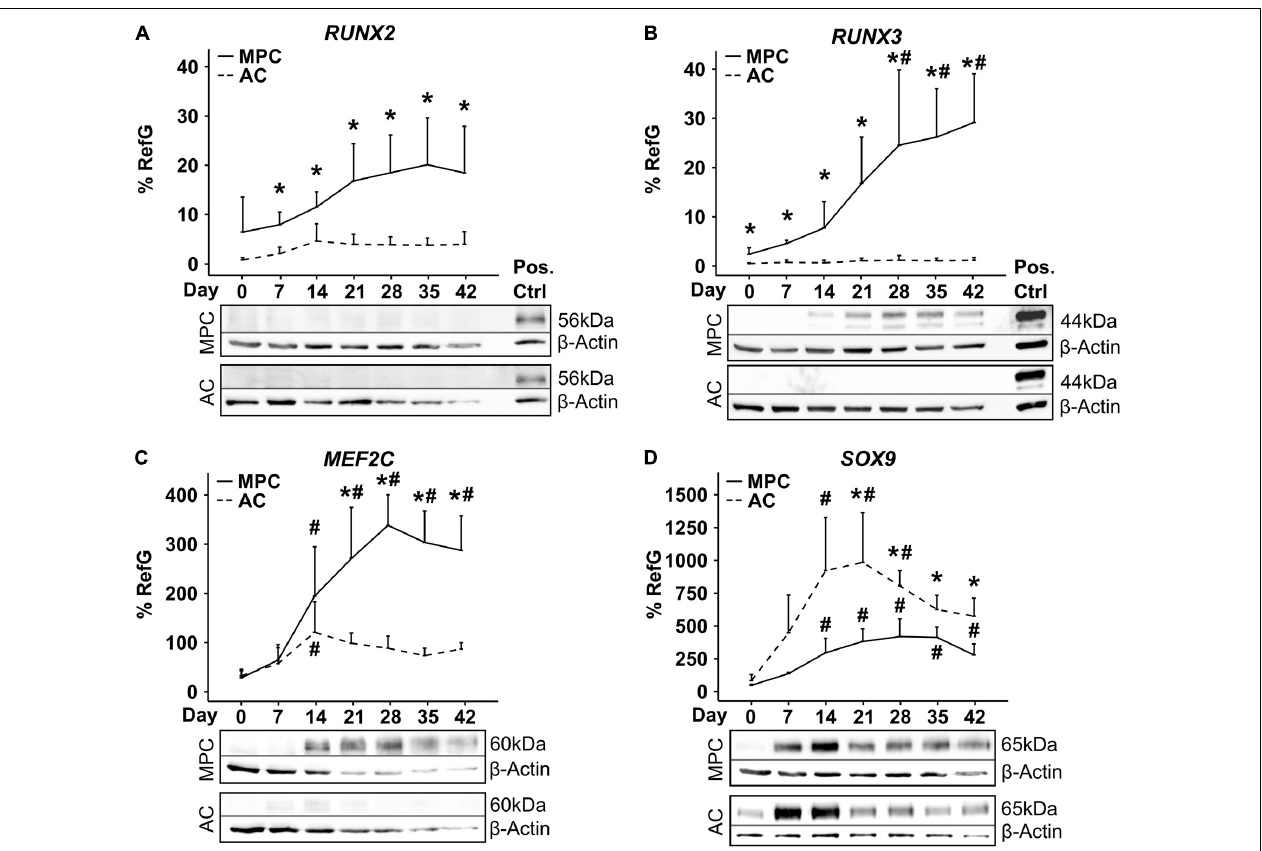
FIGURE 3 | Transcription factor regulation during MPC chondrogenesis versus AC redifferentiation. MPC and AC pellets were subjected to chondrogenic induction for 6 weeks. Samples were harvested in weekly intervals, and transcription factor levels were determined on mRNA and protein levels ( n = 4 donors). Indicated gene expression levels were determined by qPCR (A–D) and referred to reference genes HNRPH1 and CPSF6 . Data show mean ± standard deviation. MPC versus AC, Mann–Whitney U test; *, p ≤ 0.05 versus d0 ANOVA Tukey; #, p ≤ 0.05. RUNX2, RUNX3, MEF2C, and SOX9 protein levels were determined by Western blot analysis, β -actin levels were determined as internal reference, and SAOS-2 cell lysate was used as positive control on the same gel (Pos. Ctrl). Shown is one representative of three to four